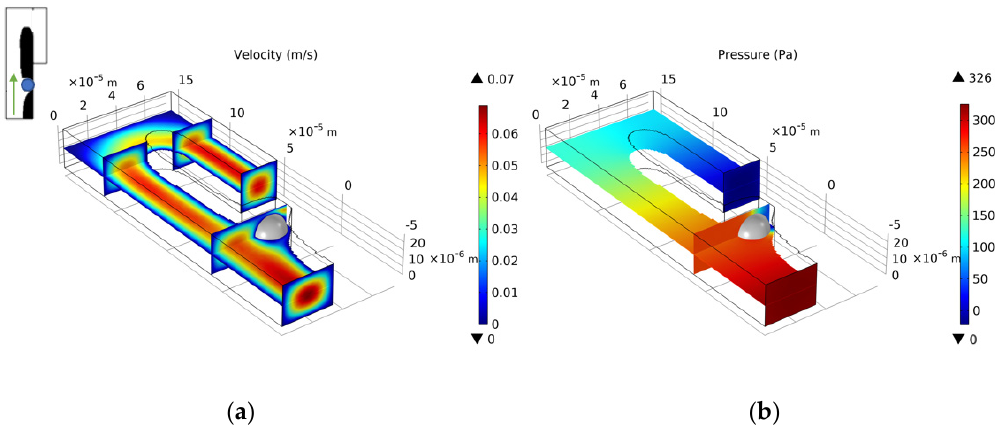
Figure 7. ( a ) The velocity field distribution and ( b ) pressure field distribution of 3D model with captured cell.